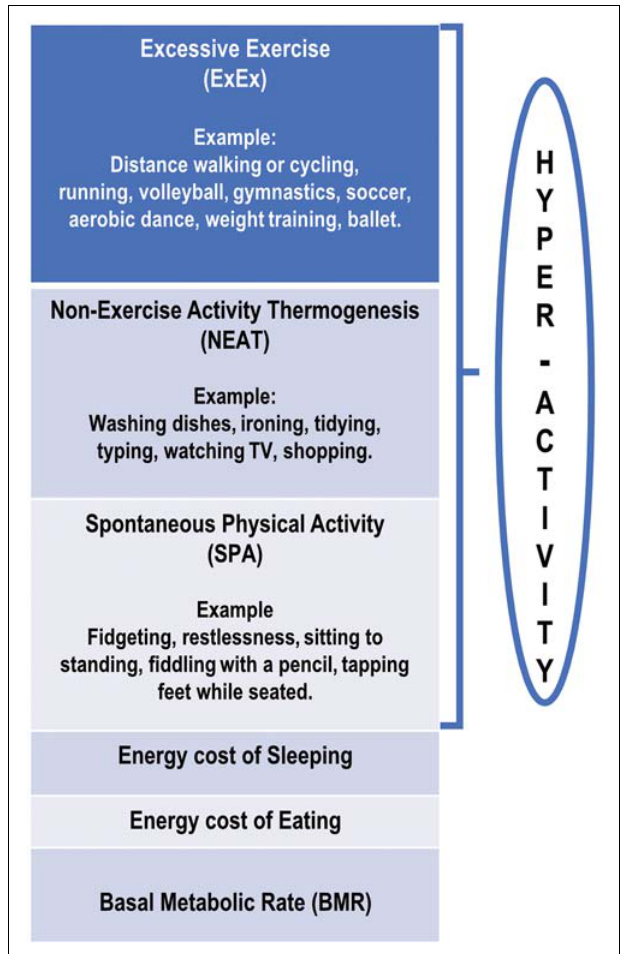
FIGURE 1 | Schematic diagram of proposed divisions of daily energy expenditure in anorexia nervosa